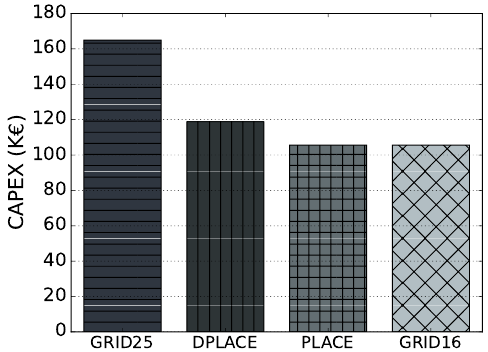
Figure 6. CAPEX for analyzed LoRaWAN gateway placement